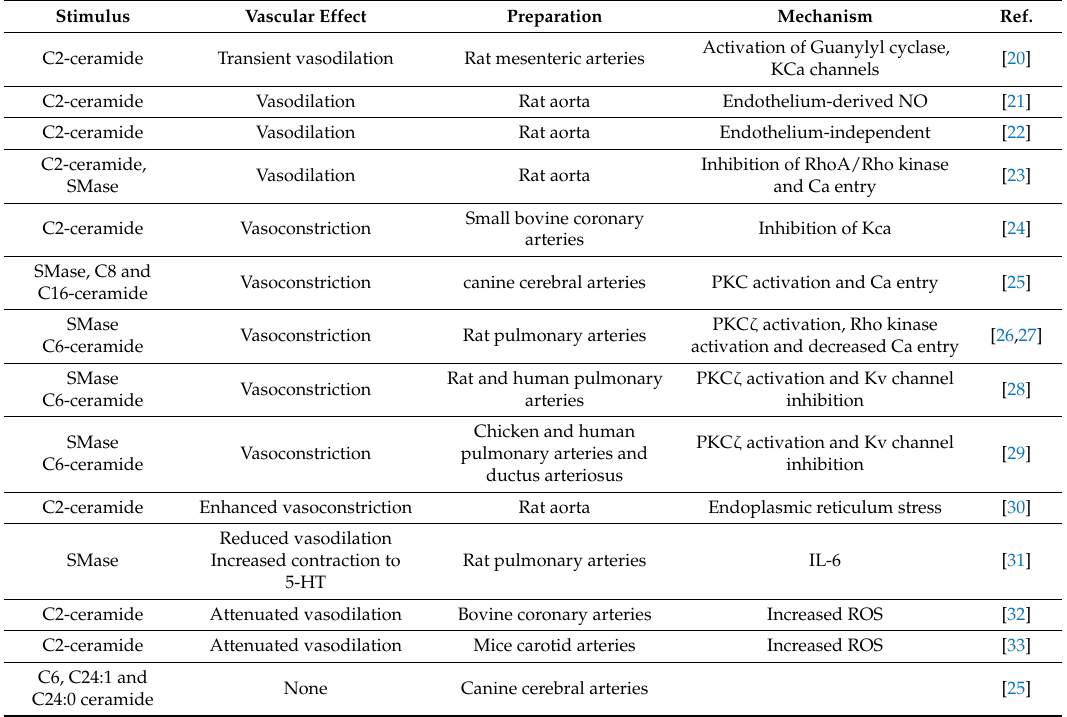
Table 1. Summary of the vasomotor effects induced by ceramide. SMases: sphingomyelinases; KCa: calcium-activated K + channels; ROS: reactive oxygen species; PKC ζ : protein kinase C ζ